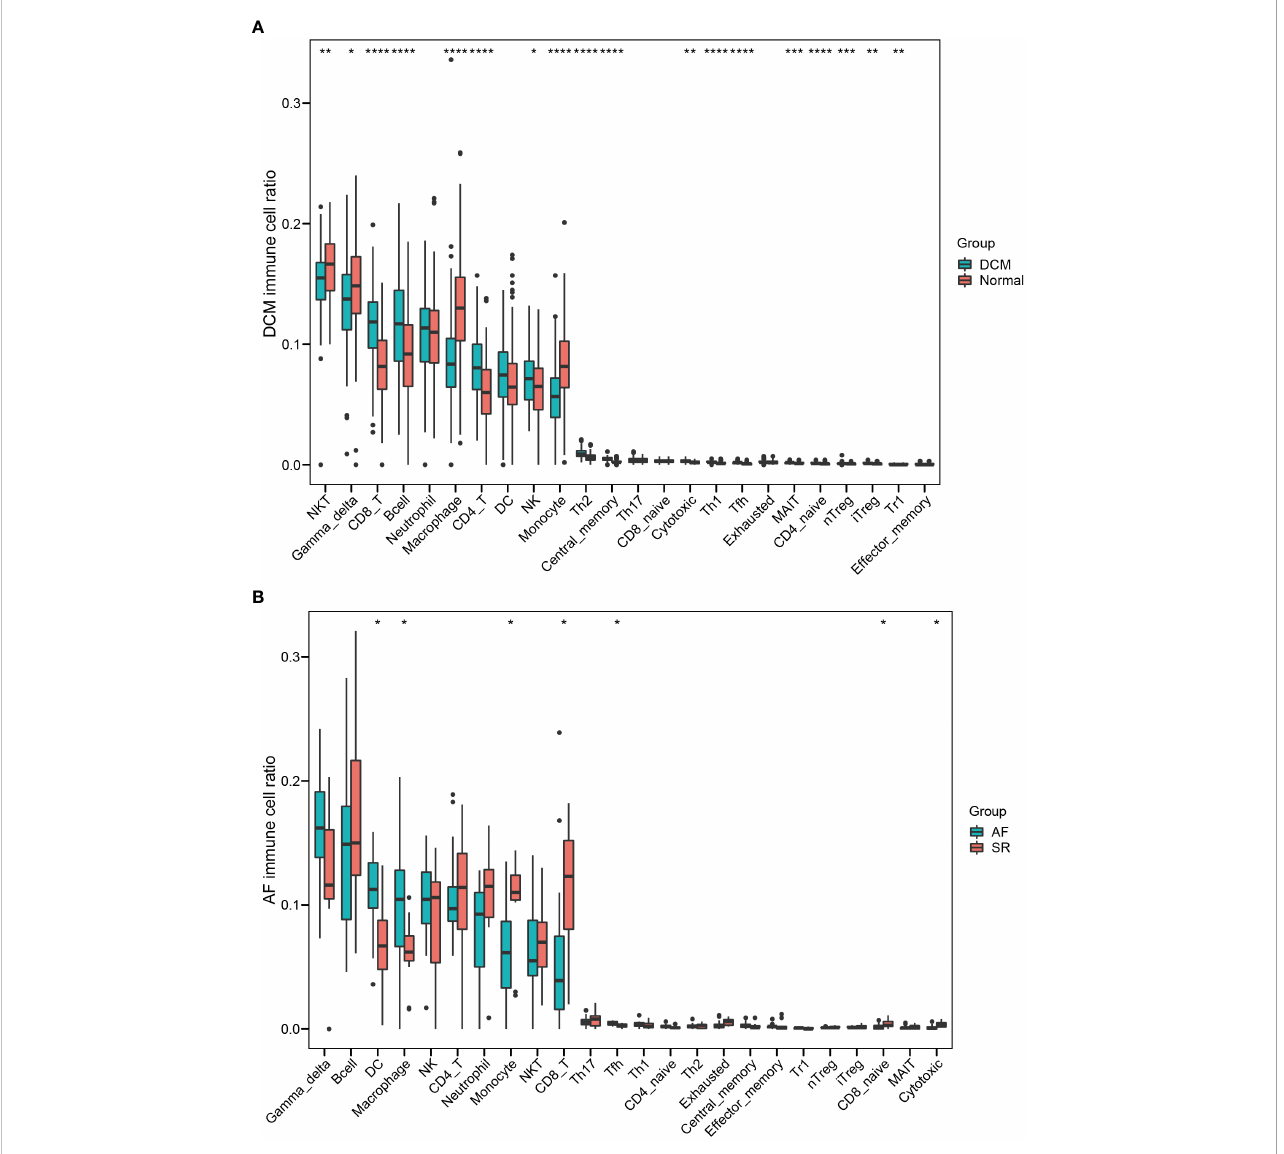
FIGURE 9 Validating the signi fi cantly different in fi ltrates of immune cells in DCM and AF. (A) Boxplot of immune cell ratio in DCM. (B) Boxplot of immune cell ratio in AF. Wilcoxon test: * P < 0.05, ** P < 0.01, *** P < 0.001, **** P <